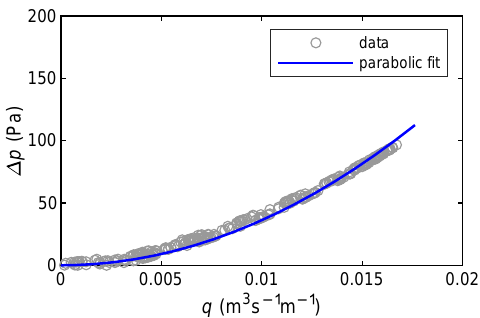
Figure 6. Pressure drop ( ∆ p ) vs. flow rate ( q ) data points and corresponding fitted parabola ( ∆ p / q 2 = const) for a wave condition with T = 1.6 s and H = 0.04 m, tested in Model 1 (data in model